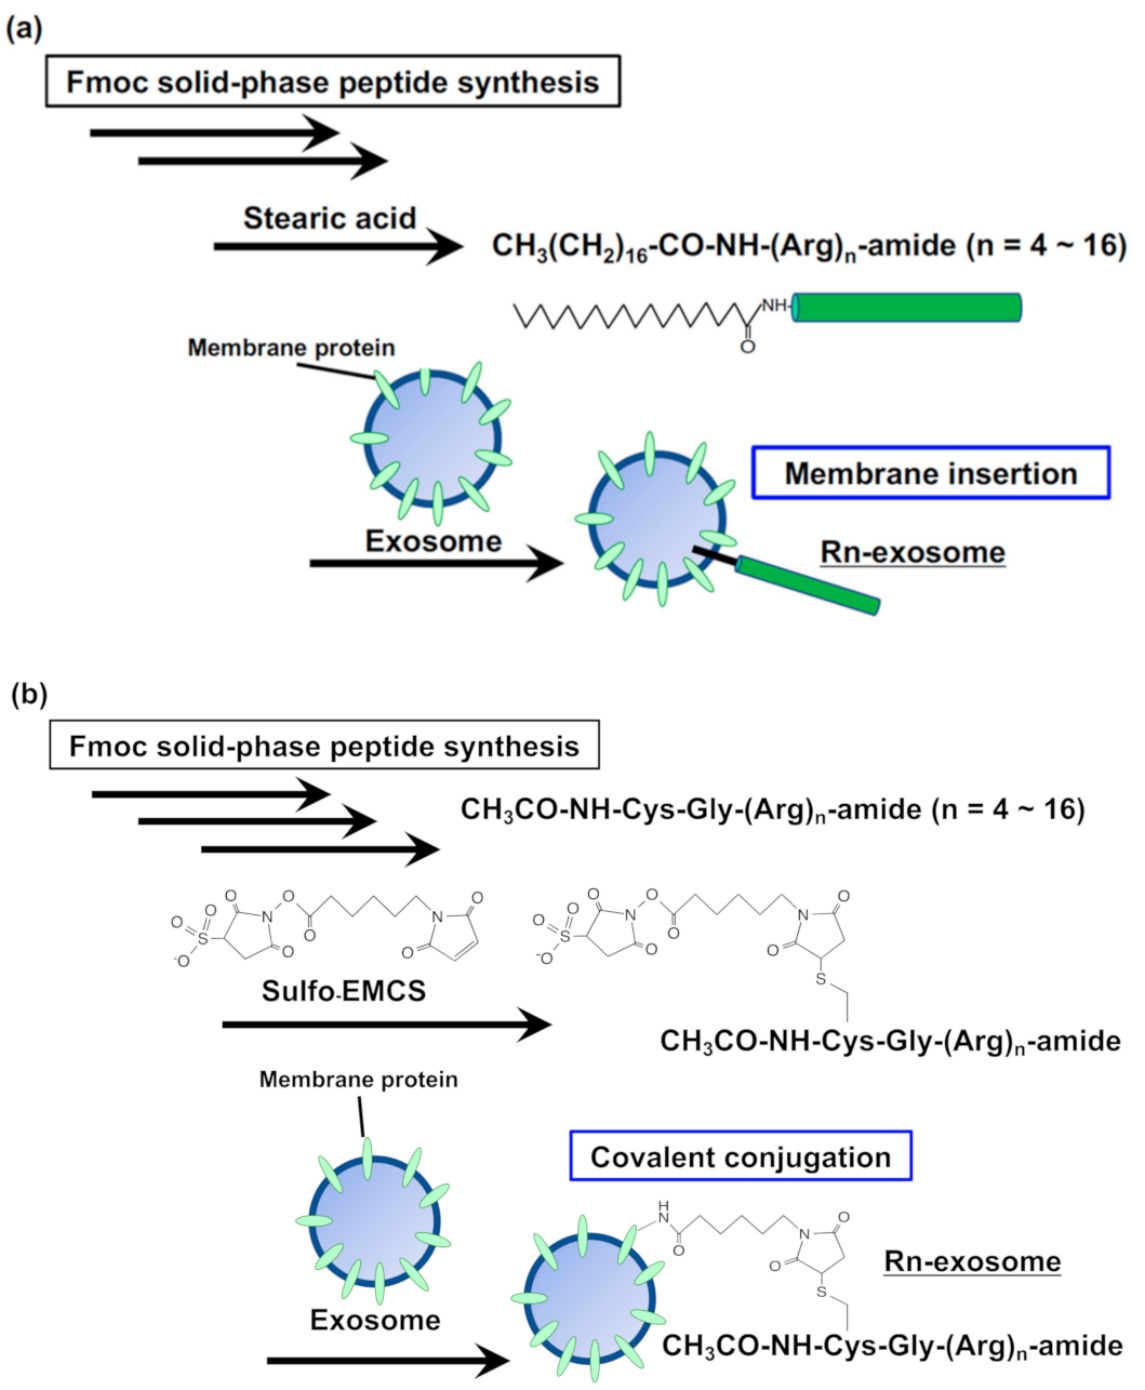
Figure 2. ( a , b ) Arginine-rich cell-penetrating peptide-modified (membrane insertion ( a ) and covalently conjugation ( b ) methods) exosomes for macropinocytosis induction and efficient recipient cellular